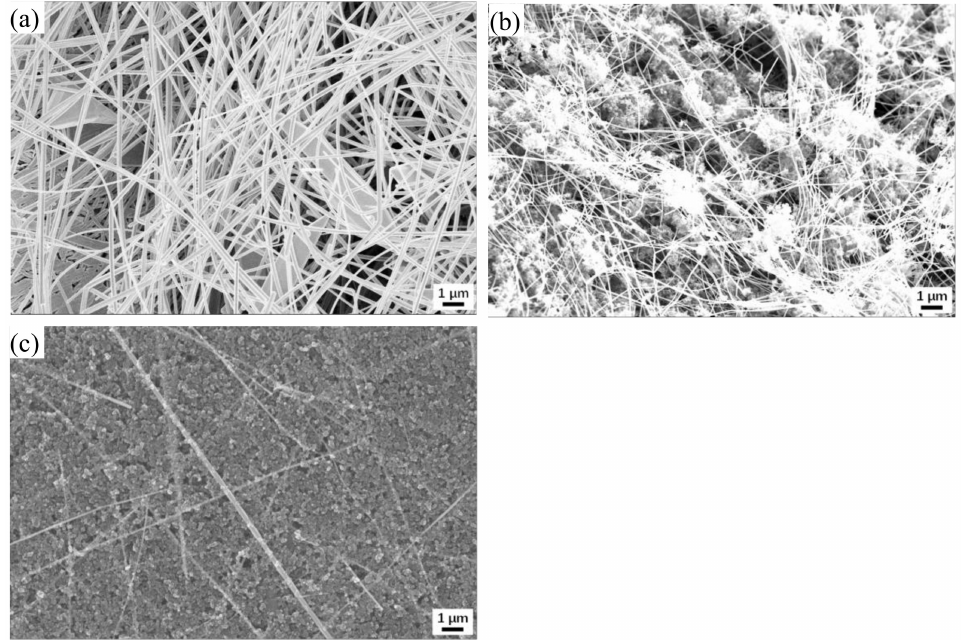
Figure 4. SEM images of ( a ) Ag NWs; ( b ) Ag NWs + 300 mg carbon black; ( c ) Ag NWs + 640 mg carbon black.